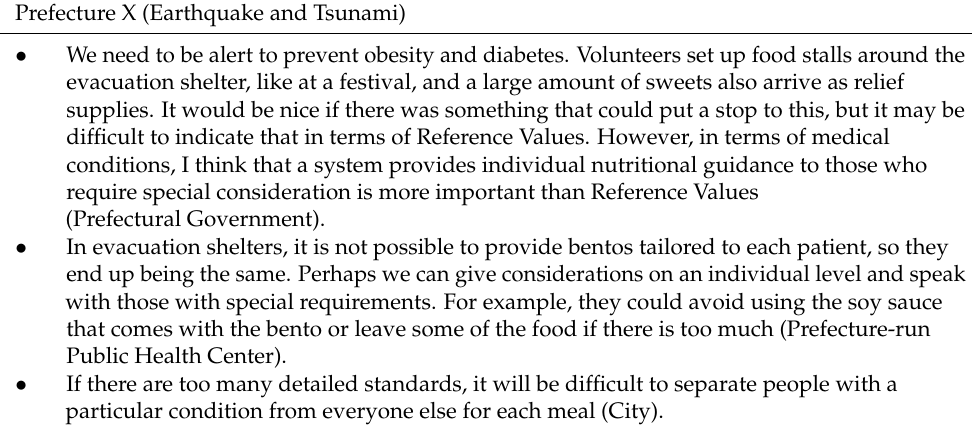
Table 12. Is there a need to address chronic conditions other than hypertension?